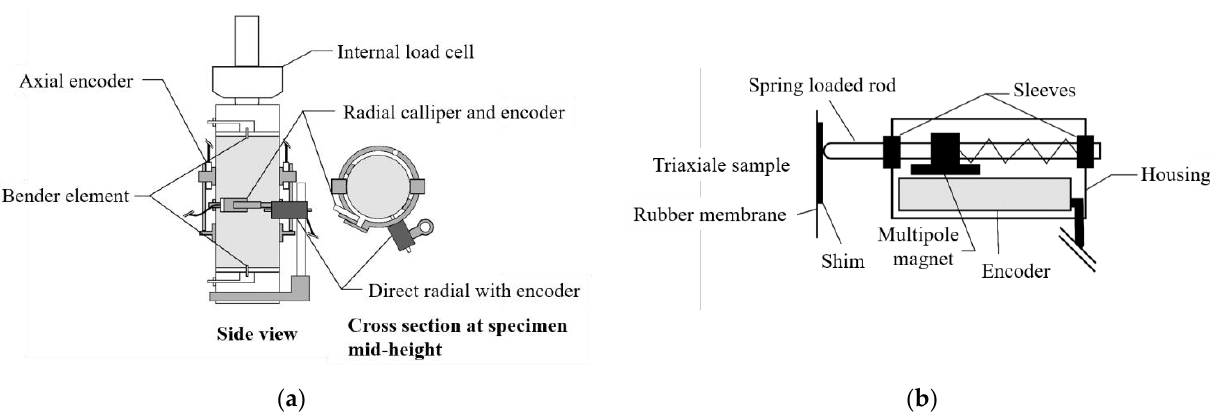
Figure 7. Magnetic encoders system with fiber Bragg grating (FBG): ( a ) small strain instrumentation; ( b ) cross section through direct radial transducer (after [35], available via 2019 license: CC BY 4.0).